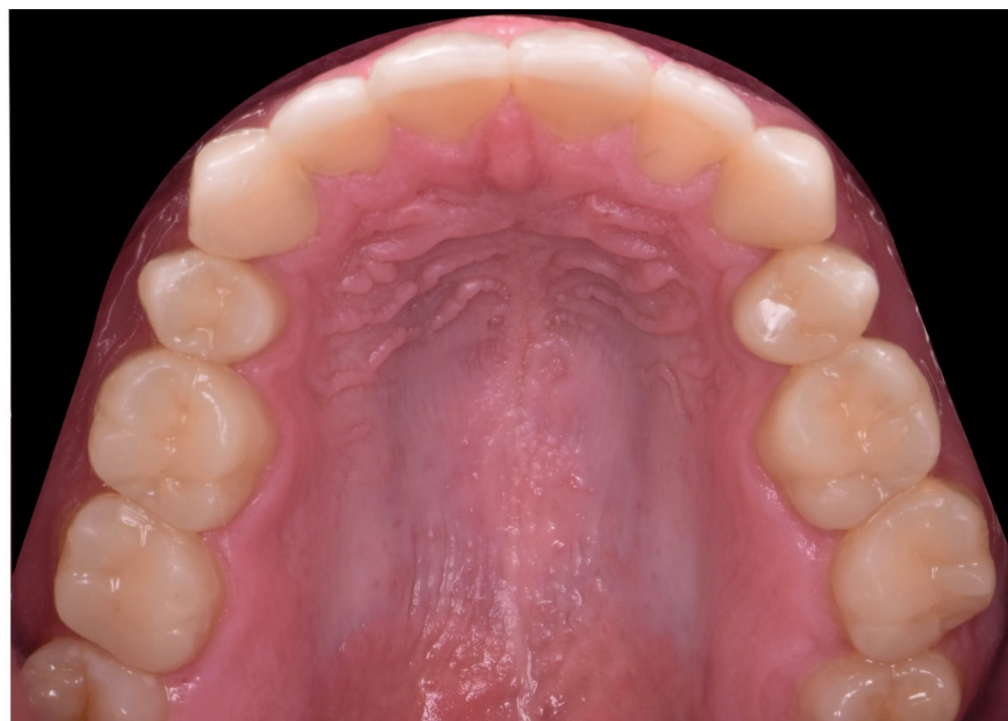
Figure 35. Final intraoral occlusal picture (upper arch).